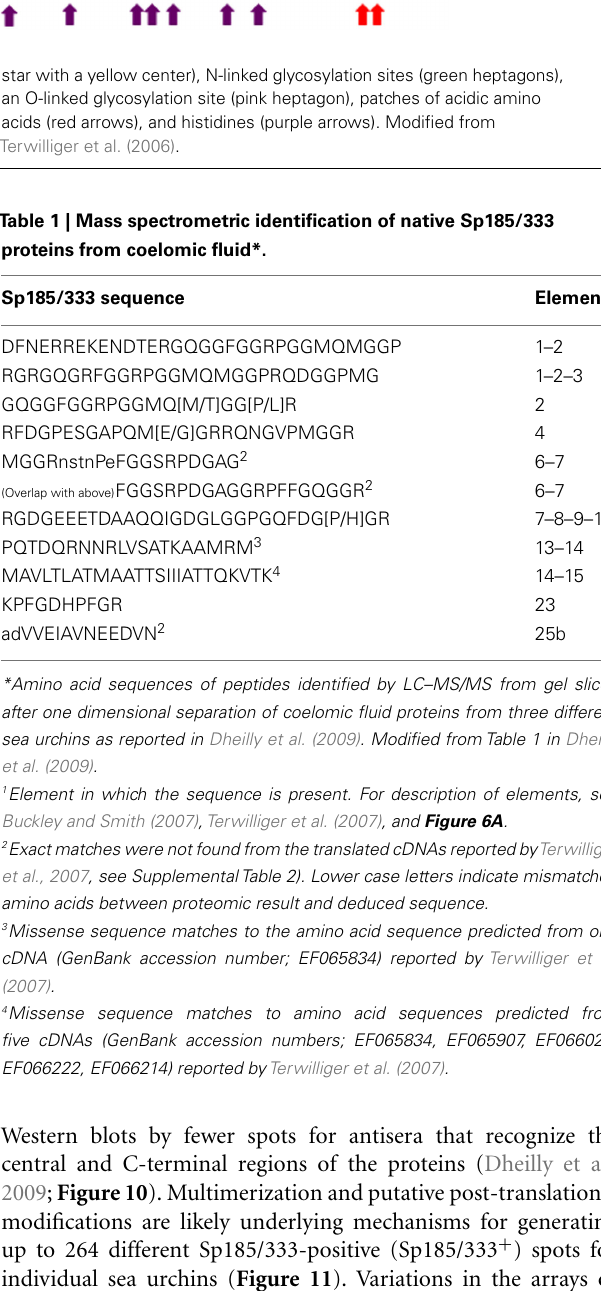
star with a yellow center), N-linked glycosylation sites (green heptagons), an O-linked glycosylation site (pink heptagon), patches of acidic amino acids (red arrows), and histidines (purple arrows). Modified from Terwilliger et al. (2006).